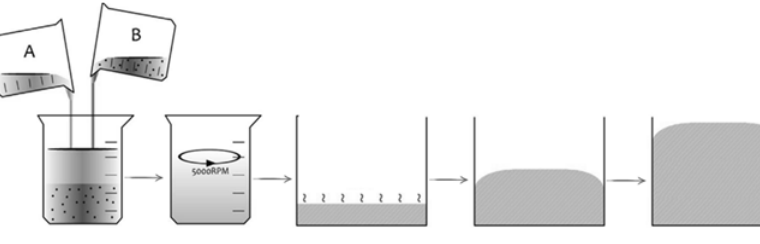
Figure 1. Scheme for drawing ‐ up the RPUF.